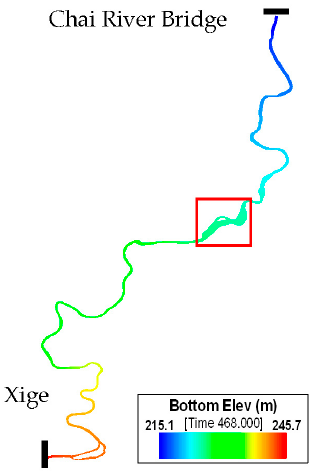
Figure 3. Bottom elevation diagram for urban section of the Mudan River trunk stream.